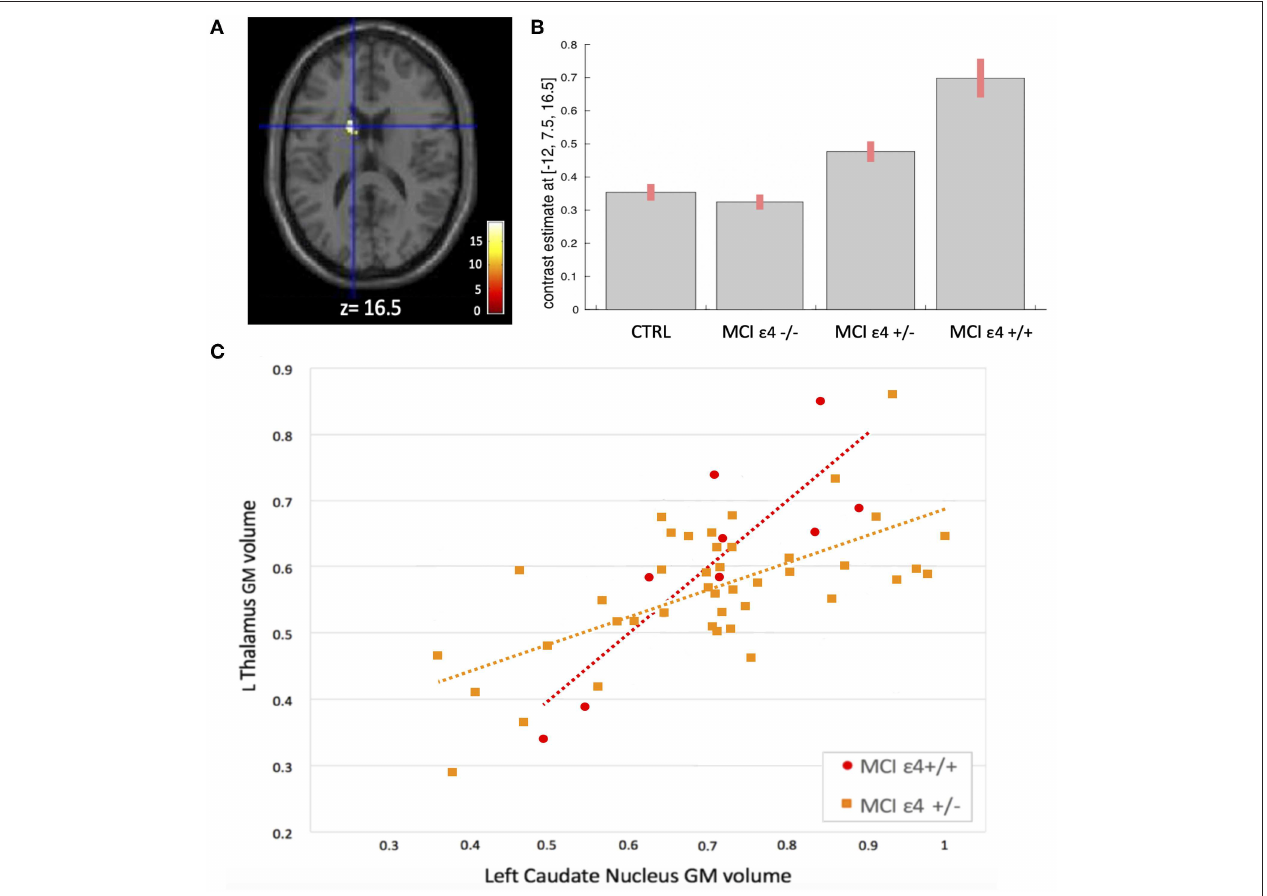
FIGURE 4 | (A) Voxels that expressed the difference in structural association between the left thalamus and the left caudate nucleus among the groups. (B) Plots depicting mean differences among the groups within region of statistical significance in structural covariance analysis. (C) Correlations between GM volumes extracted from 4-mm radius sphere centered on the ROI and the peak voxel expressing increased structural association in the MCI ε 4 + / + and in MCI ε 4 + / −